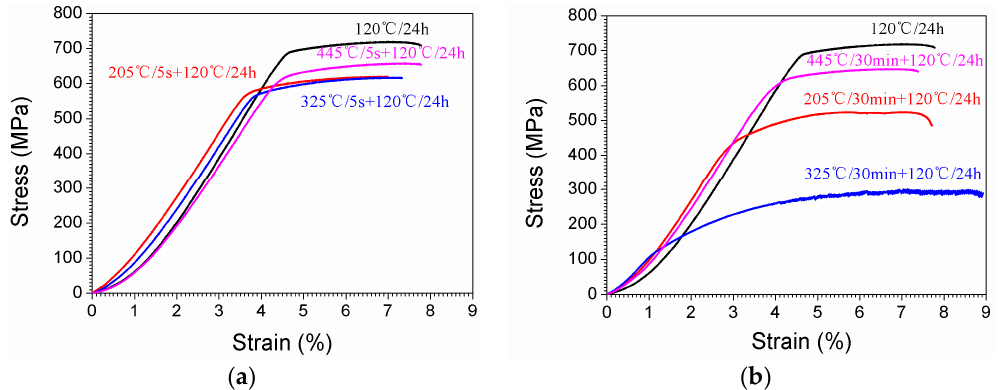
Figure 10. Stress-strain curves of the tensile samples having been isothermal heat treated at 205 °C, 325 °C, and 445 °C for different durations (5 s and 30 min), then aging at 120 °C for 24 h. ( a ) the isothermal heat treated time is 5 s; ( b ) the isothermal heat treated time is 30 min.